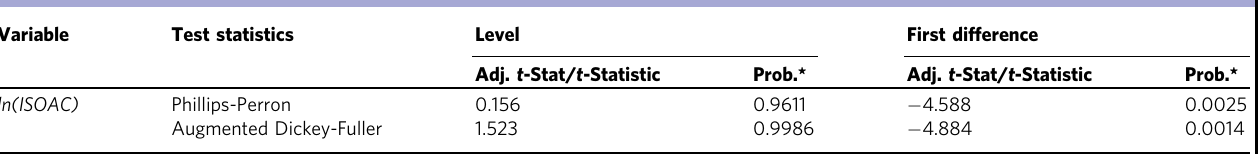
Table 3 Unit-root test of the incidents of sexual offences against